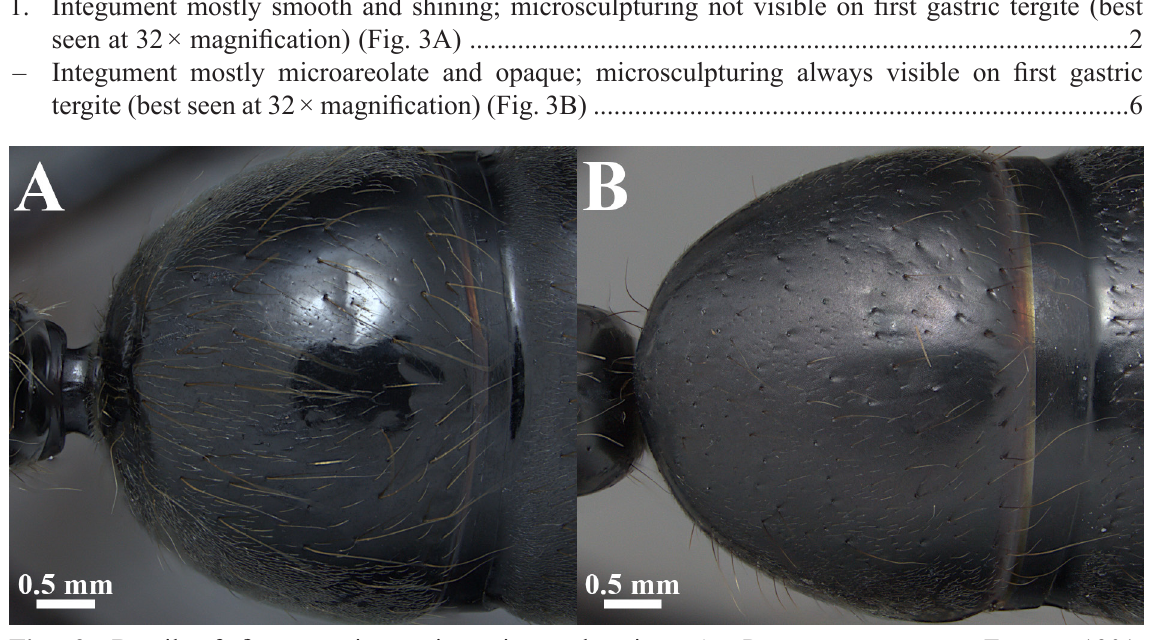
Fig. 3. Detail of first gastric tergite microsculpturing. A . Dinoponera mutica Emery, 1901.